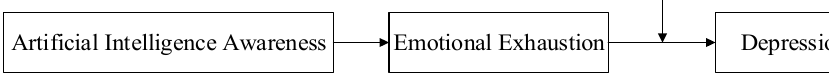
Figure 1. The theoretical framework.